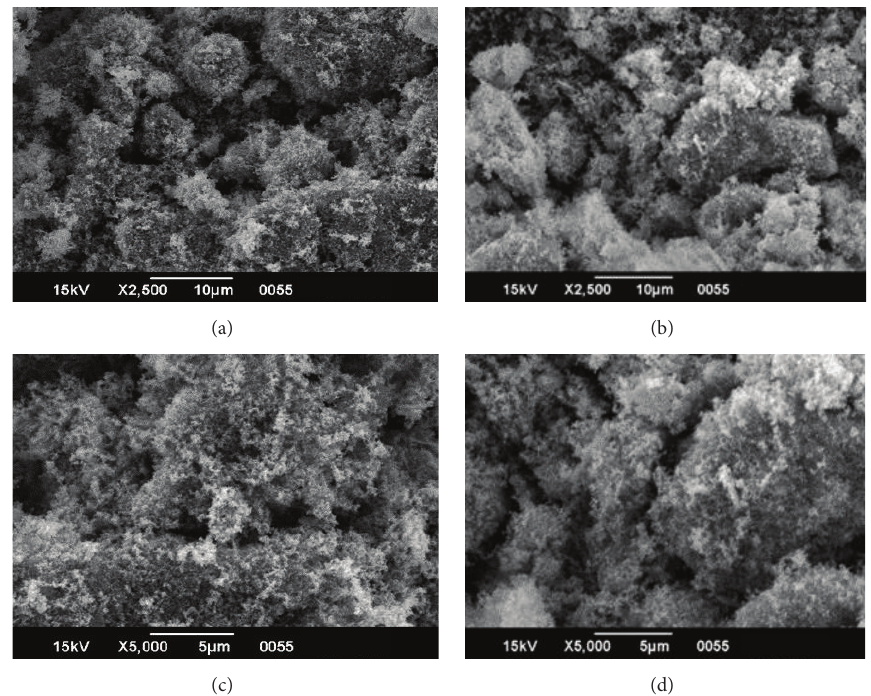
Figure 4: SEM micrographs of Fe 3 O 4 nanoparticles ((a), (c)) and Ag-doped Fe 3 O 4 nanoparticles ((b), (d)) at different magnifications.